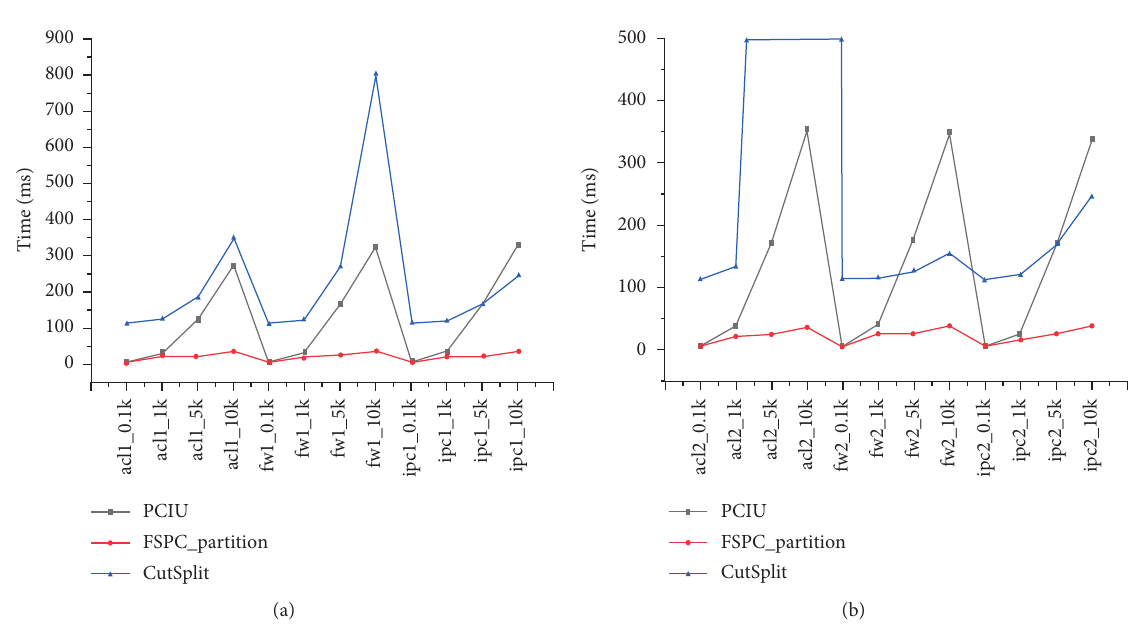
Figure 7: Comparisons of preprocessing time for different rule sets.